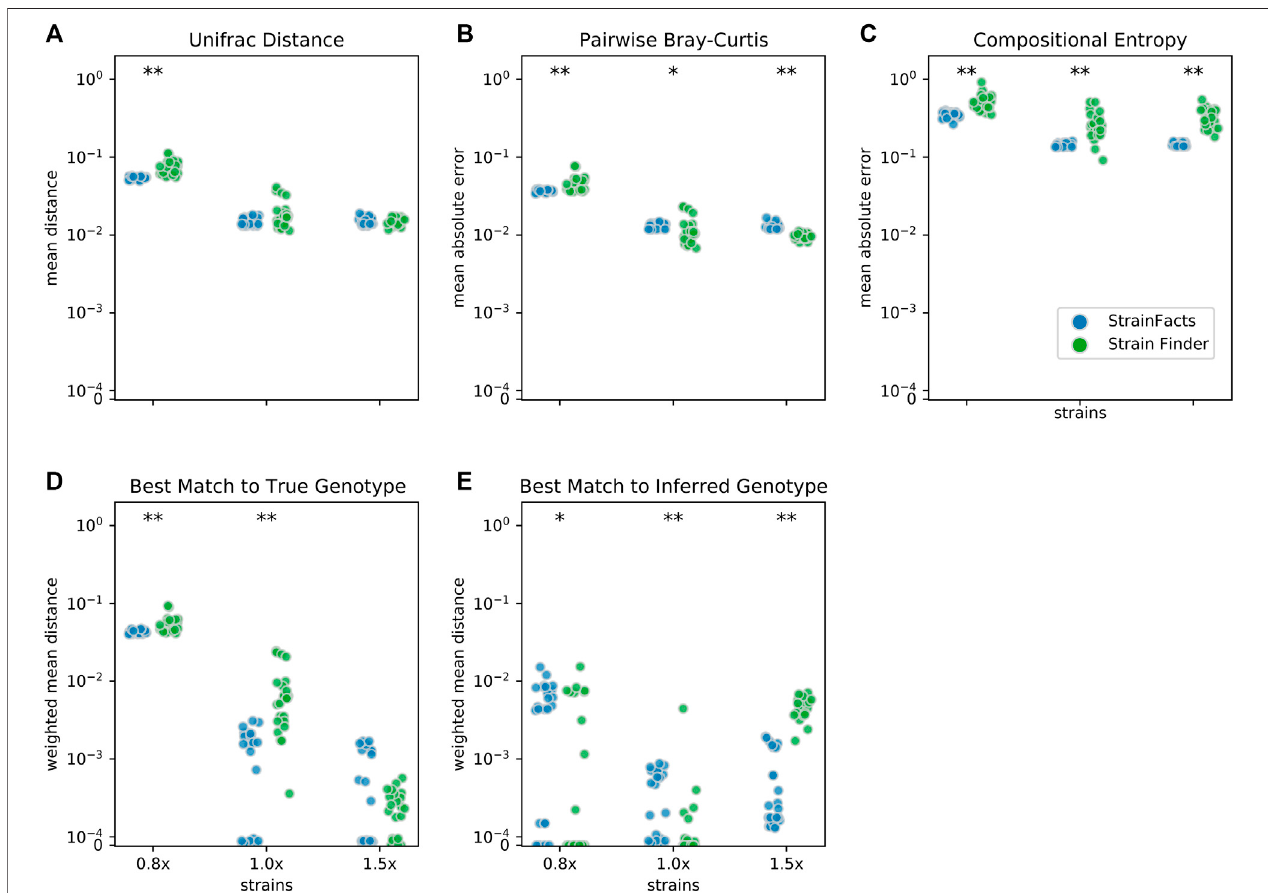
FIGURE 2 | Accuracy of strain inference on simulated data. Performance of StrainFacts and Strain Finder are compared across fi ve distinct accuracy indices, with lower scores re fl ecting better performance on each index. Simulated data had 200 samples, 40 underlying strains, and 250 SNPs. For each tool, 32, 40, and 60 strain models were parameterized ( “ 0.8x ” , “ 1x ” , and “ 1.5x ” respectively), and every model was fi t with fi ve independent initializations to each simulation. All 25 estimates for each tool-parameterization combination are shown. Scores re fl ect (A) mean Unifrac distance between simulated and inferred strain compositions, (B) mean absolute difference between all-by-all pairwise Bray-Curtis dissimilarities calculated on simulated versus inferred strain compositions, (C) mean absolute difference in Shannon entropy calculated on simulated versus inferred strain compositions, (D) abundance weighted mean Hamming distance from each ground-truth strain to its best-match inferred genotype, and (E) the reverse: abundance weighted mean Hamming distancefrom each inferred strain to its best-match true genotype. Markers at the top ofeach panel indicate a statistical difference between tools at a p < 0.05 (*) or p < 0.001 (**) signi fi cance threshold by Wilcoxon signed-rank test. A version of this fi gure that includes accuracy comparisons to MixtureS is included as Supplementary Figure S3